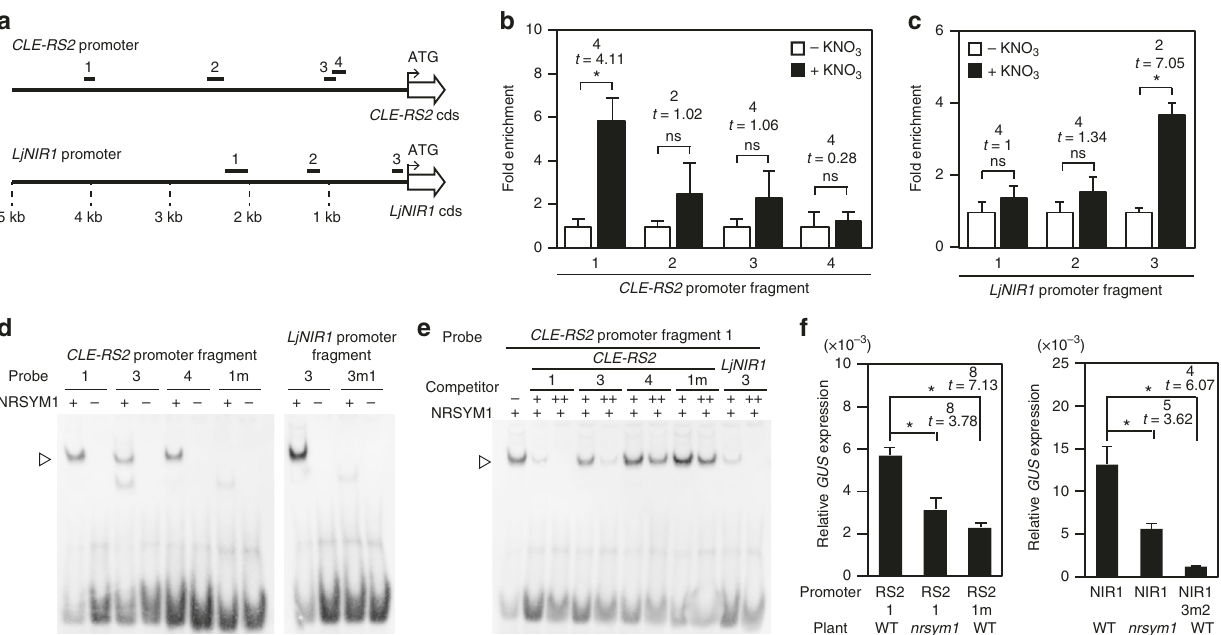
Fig. 6 Interaction of NRSYM1 with CLE-RS2 and LjNIR1 promoters. a A schematic diagram of the location of DNA fragments used for ChIP-qPCR analyses and electrophoretic mobility shift assay (EMSA) in the 5 kb promoter regions of CLE-RS2 and LjNIR1 . The numbering of fragments within each promoter region corresponds to those referenced in ( b – e ). ( b , c ) qPCR analysis to examine NRSYM1 binding with the ( b ) CLE-RS2 and ( c ) LjNIR1 promoter regions after ChIP. DNA fragments were co-immunoprecipitated with polyclonal anti-myc antibody from chromatin suspensions prepared from pLjUBQ:NRSYM1- myc roots that were incubated with 0 or 10 mM KNO fi ed by comparison with products ampli fi ed 3 for 24 h without rhizobia. The PCR products were quanti using primers speci fi c to LjUBQ . The fold enrichment of nitrate-induced NRSYM1 binding was calculated as the ratio between +KNO 3 and – KNO 3 - immunoprecipitated ampli fi cation signals. Error bars indicate SEM ( n = 3 independent pools of roots). ( d , e ) EMSA showing NRSYM1-binding with the NRE/NBS of the CLE-RS2 and LjNIR1 promoter (Supplementary Fig. 8b). Biotin-labeled probes were incubated with NRSYM1(531 – 976)-myc (+) or in vitro translation products without template ( − ). The CLE-RS2 promoter 1m and LjNIR1 promoter 3m1 contain mutations in the NRE/NBS of CLE-RS2 promoter 1 and LjNIR1 promoter 3, respectively (Supplementary Fig. 8b; Supplementary Table 2). e NRSYM1 (531 – 976)-myc and a labeled CLE-RS2 promoter 1 probe were incubated with their respective competitors. Non-labeled probes were used as competitor DNA at an excess molar ratio ( – , 1:0; +, 1:20; ++, 1:100). Arrowheads indicate locations of the band shift. f Real-time RT-PCR analysis of GUS expression in WT and nrsym1-1 transgenic hairy roots expressing each GUS construct (Supplementary Fig. 8d). Each cDNA sample was prepared from total RNA derived from an uninoculated whorl of roots grown in the presence of 10 mM KNO 3 for 24 h. Transgenic roots were identi fi ed by GFP fl uorescence. The expression of GFP was used as the reference. Error bars indicate SEM ( n = 5 independent pools of roots). * P < 0.05 by Student ’ s t -test. ns, not signi fi cant. Degrees of freedom are shown above the t